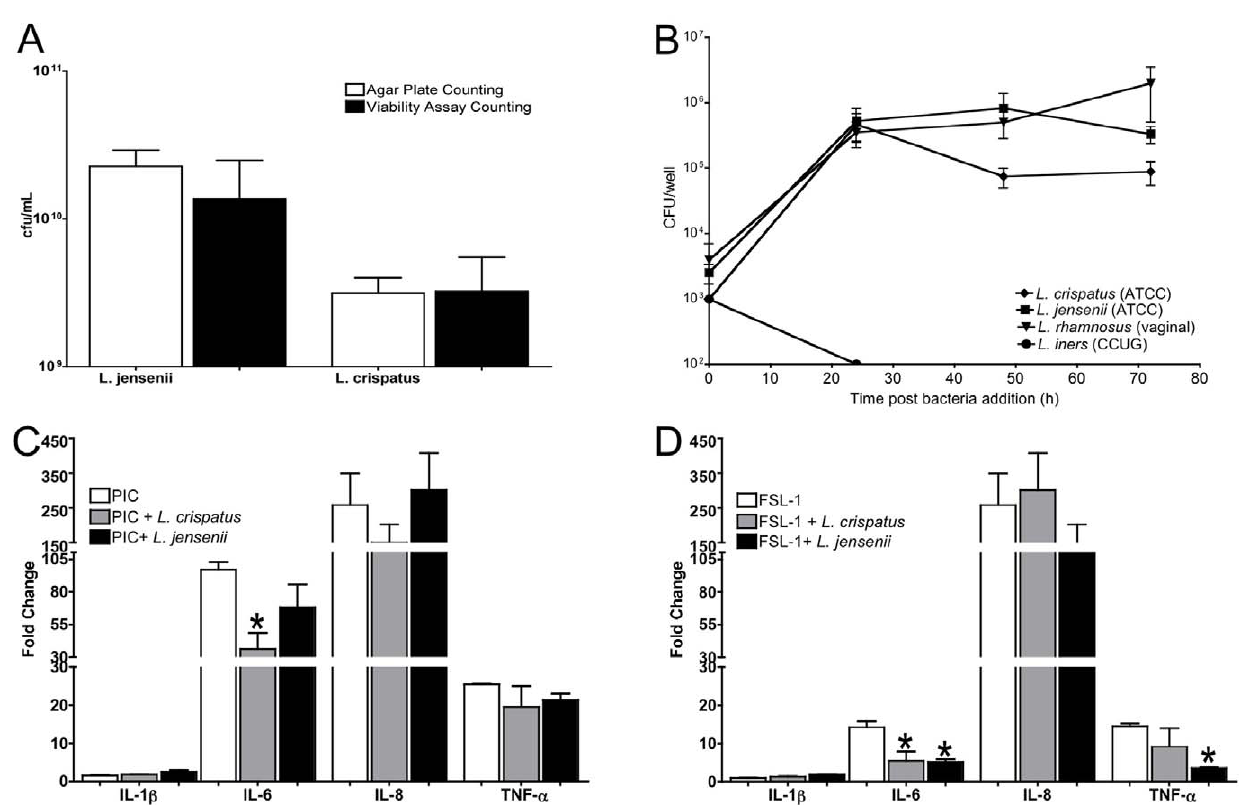
Figure 3. Commensal bacteria colonization kinetics and impact on VEC multilayer cultures. A. A higher-throughput broth-based bacterial titration system was validated against standard agar plating and subsequent colony counting. Comparison of the two methods showed no statistical differences in viability quantification (p . 0.05, Student’s t-test) supporting subsequent use of the broth-based viability assay. Data are the mean 6 SEM of duplicate samples from 2 independent experiments. B. Replication kinetics and steady state formation of L. crispatus , L. jensenii or L. iners (10 3 cfu/well) in VEC multilayer cultures are shown over 72 h. L. iners viability rapidly decreased and no viable bacteria were observed after 24 h. L. crispatus and L. jensenii viability significantly (*, p , 0.05, Student’s t-test) increased after 24 h of culture and was maintained over the study period. Each time point for the selected bacterial species represents the mean 6 SEM for triplicate wells of each VEC type (V11I, V12I, V19I) from 2 independent experiments. C and D . Colonization of the VEC by L. crispatus and L. jensenii differently impacted responses to TLR agonists (PIC or FSL- 1, respectively) as indicated by the fold change in cytokine levels relative to non-colonized cultures treated in parallel. Data are the mean 6 SEM of 3 replicates from a representative experiment out of 3 independent